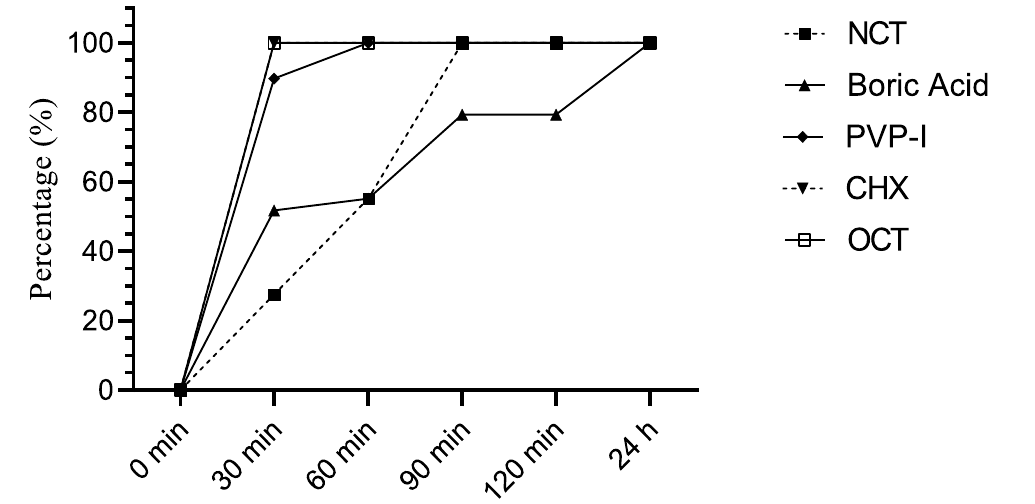
Figure 1. Percentage of C. albicans strains (n = 29) reduced by ≥4 log 10 by antiseptics after indicated incubation periods.